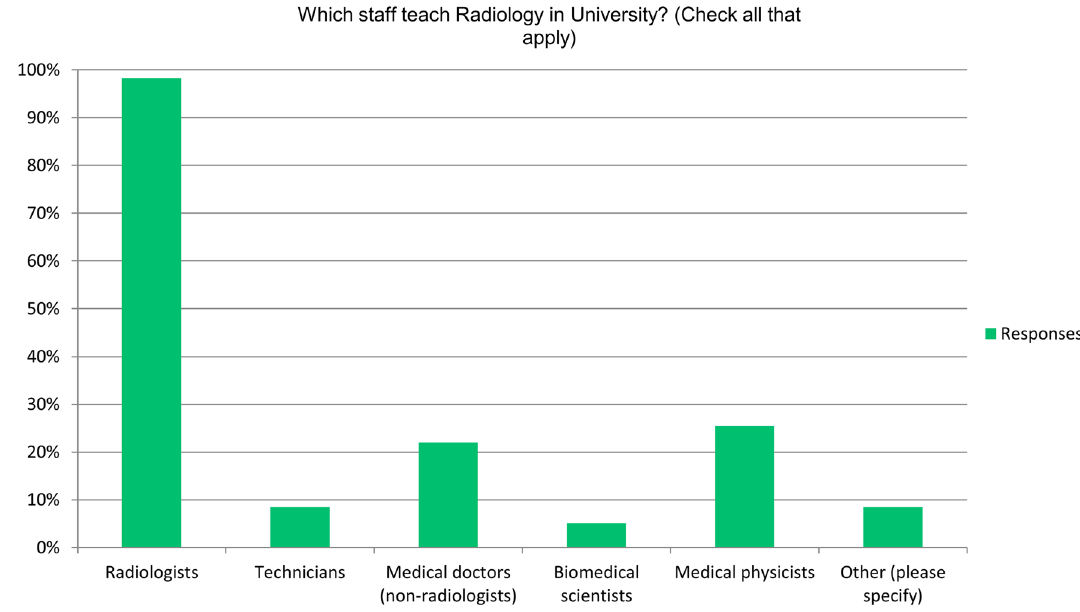
Fig. 3 Frequency plot showing the type of staff delivering radiology